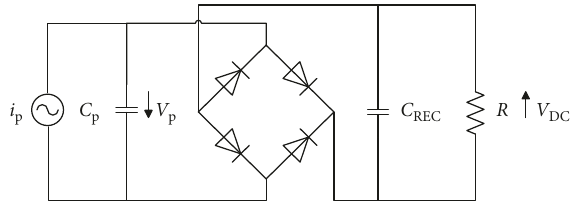
Figure 2: Schematic of the standard energy extraction